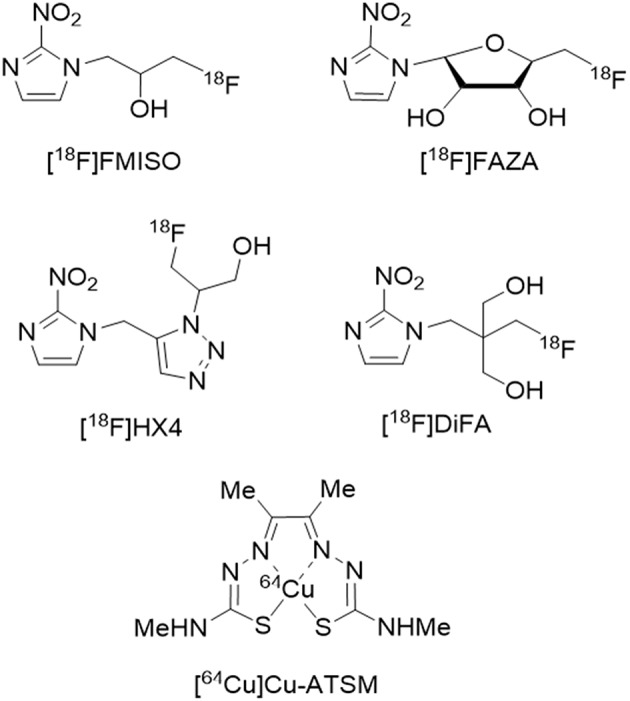
Chemical structure of the various PET tracers designed for hypoxia imaging.